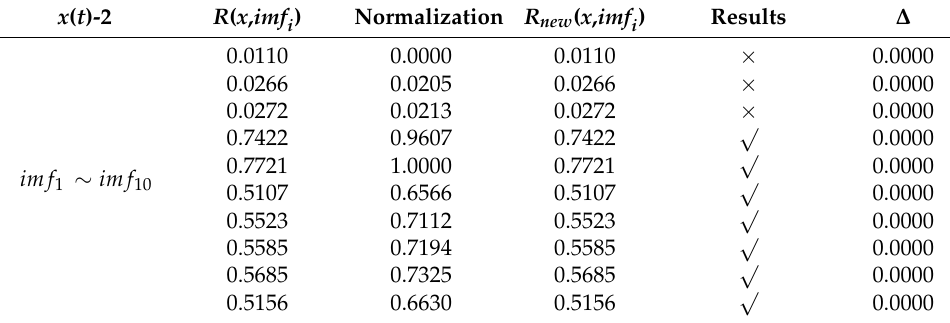
Table 3. Correlation coefficient of IMFs ( x ( t )-2).